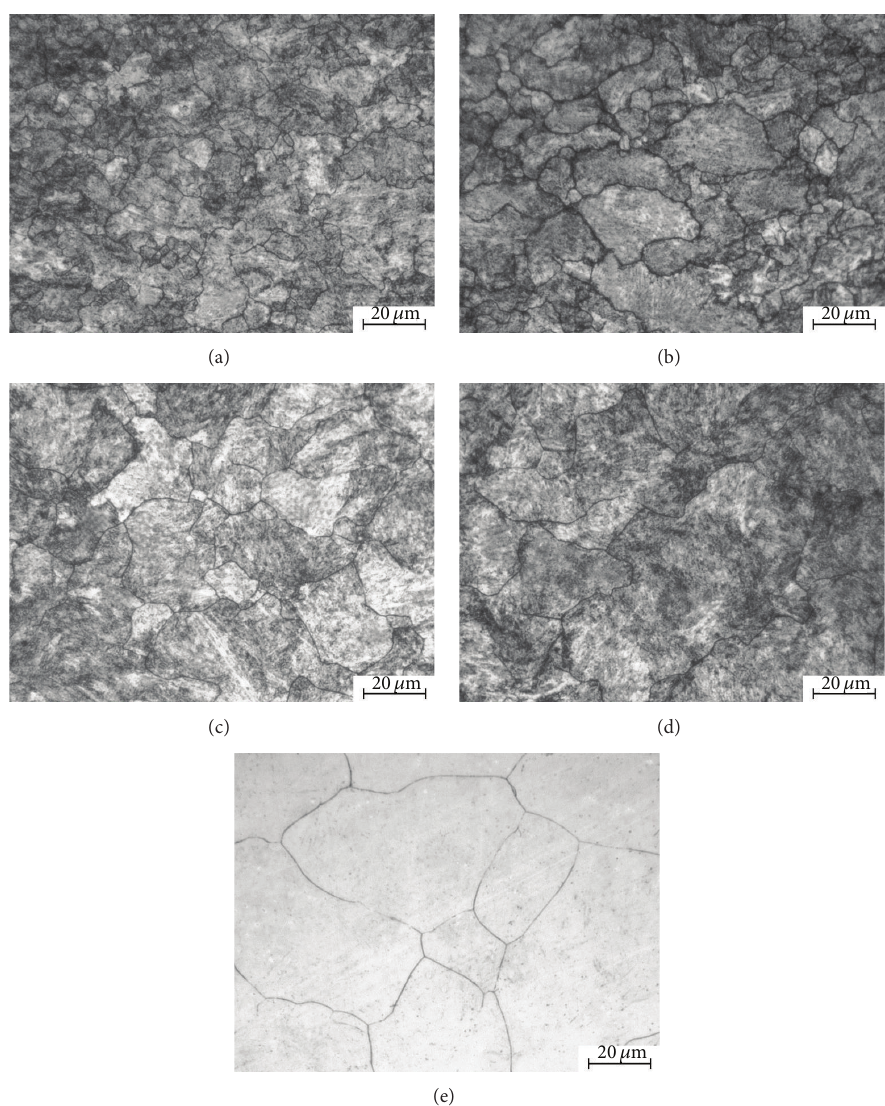
Figure 12: The microstructure of specimens deformed at (a) T = 950 ∘ C, ̇𝜀 = 0.01 s −1 , (b) T = 1000 ∘ C, ̇𝜀 = 0.01 s −1 , (c) T = 1050 ∘ C, ̇𝜀 = 0.01 s −1 , (d) T = 1100 ∘ C, ̇𝜀 = 0.01s −1 , and (e) T = 1150 ∘ C, ̇𝜀 = 0.01 s −1